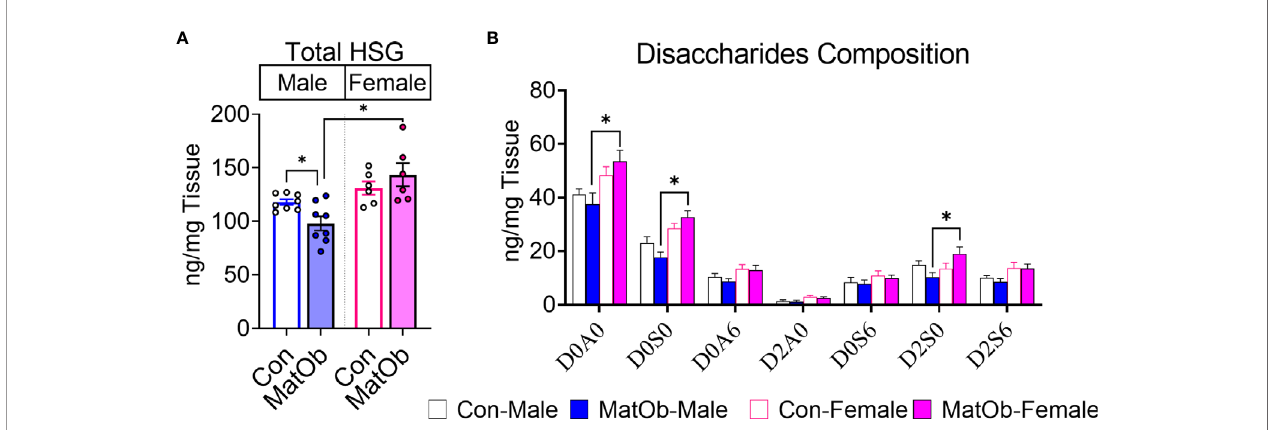
FIGURE 4 | P21 MatOb offspring have sex-speci fi c changes in total pancreatic heparan sulfate glycosaminoglycan (HSG). (A) Total pancreatic HSG in male MatOb offspring was decreased, while female MatOb offspring appeared to have the signi fi cantly higher HSG compared to male MatOb offspring (n=6-8/group). (B) HSG disaccharide composition analysis showed P21 female MatOb offspring had signi fi cantly increase D0A0 and D0S0 disaccharides (n=6-8/group; disaccharide structure code letters/numbers: D: D 4,5-unsaturated uronic acid, A: N=Acetylglucosamine, S: N-Sulfoglucosamine, 0: no sulfation,2: 2-O-sulfation; 6: 6-O-sulfation). Experimental animals were originated from at least 3 separate litters (*p <